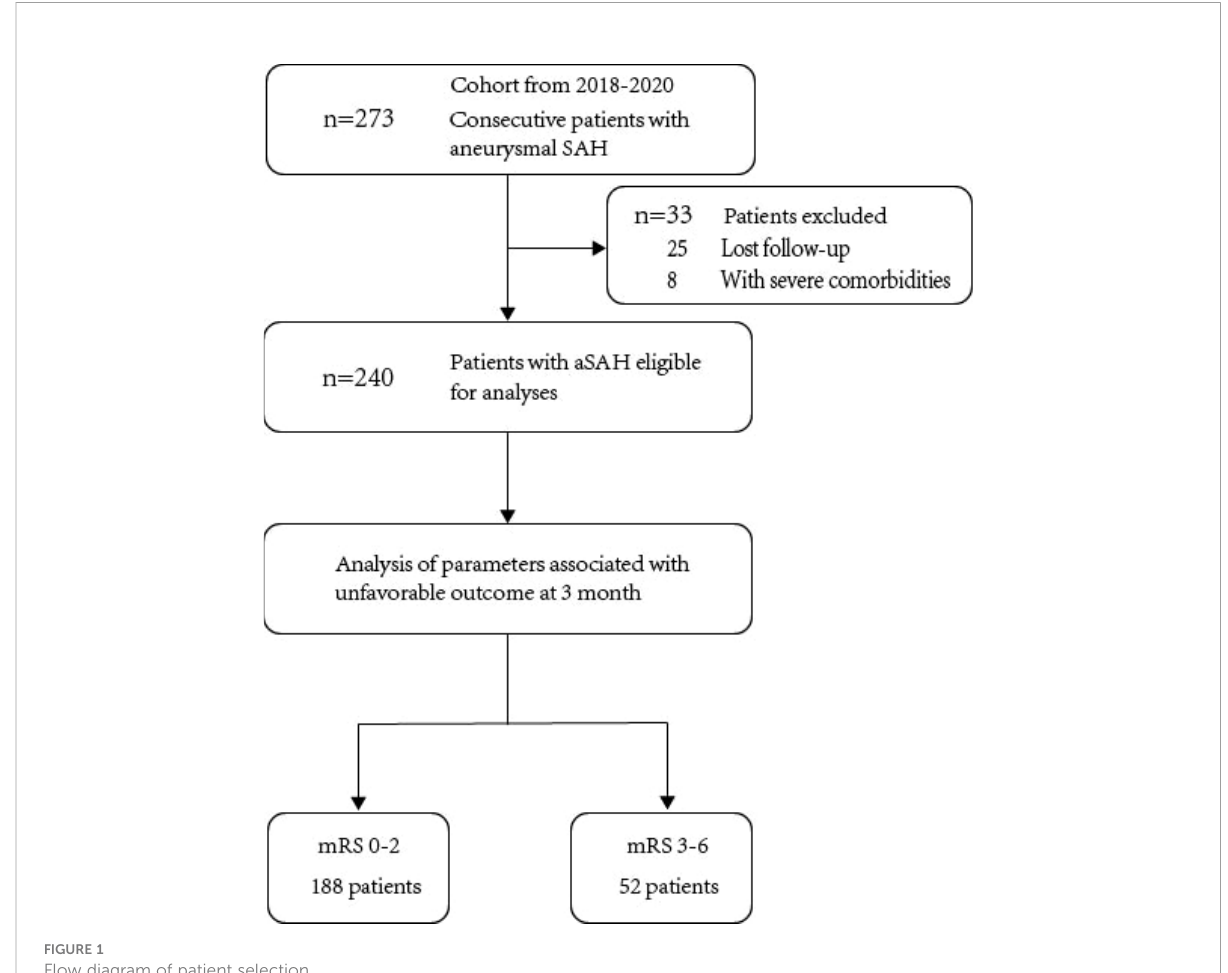
FIGURE 1 Flow diagram of patient